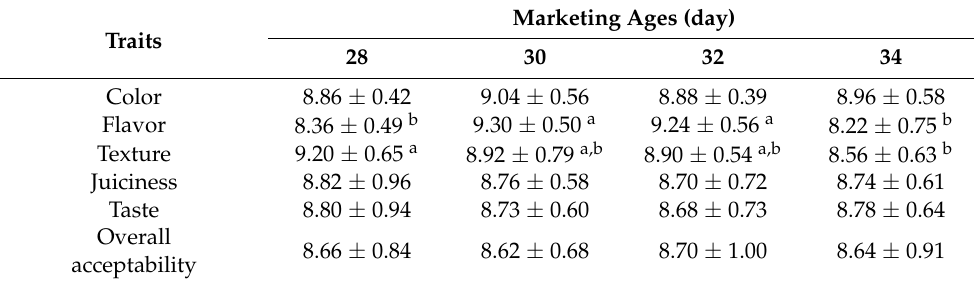
Table 5. Sensory evaluation of cooked cured chicken breast with various marketing ages. Traits